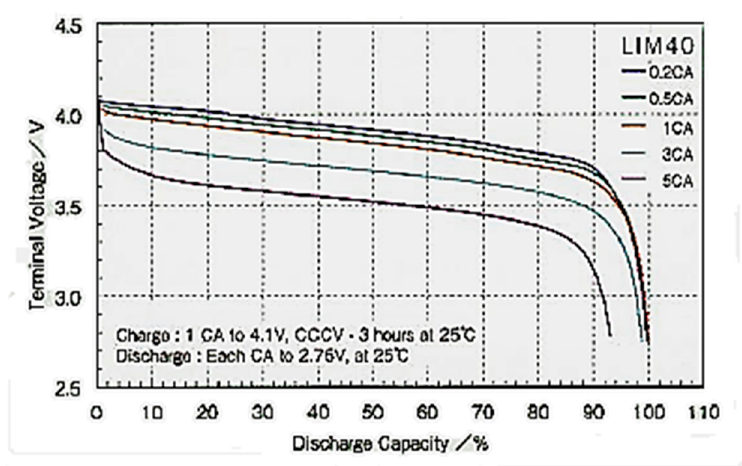
Energies 2019 , 8 , x FOR PEER REVIEW Figure 4. Discharge characteristics of LIM40-7D cell ( Reproduced courtesy of the GS Yuasa) [11].